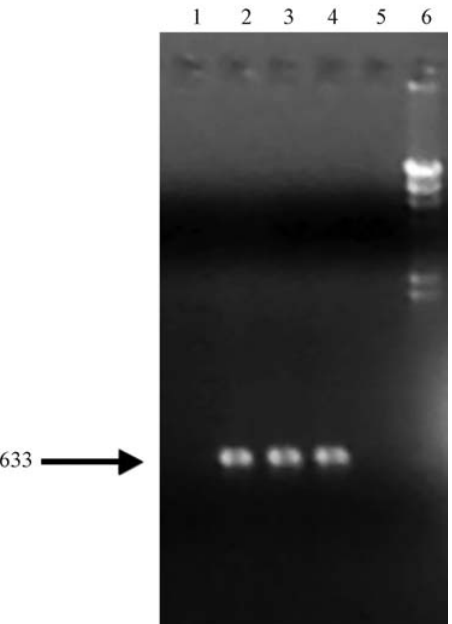
Figure 6 - Identification of extrachromosomal copy of ICEH. Genomic DNA from M. hyopneumoniae strains J (5) and 7448 (2-4) were used in PCR reactions with primers ICEH1-F and ICEH2-R. (1) negative control and (6) Lambda DNA digested with Hin dIII. Arrow shows the 633 amplicomfromdifferentDNAsamplesof M.hyopneumoniae